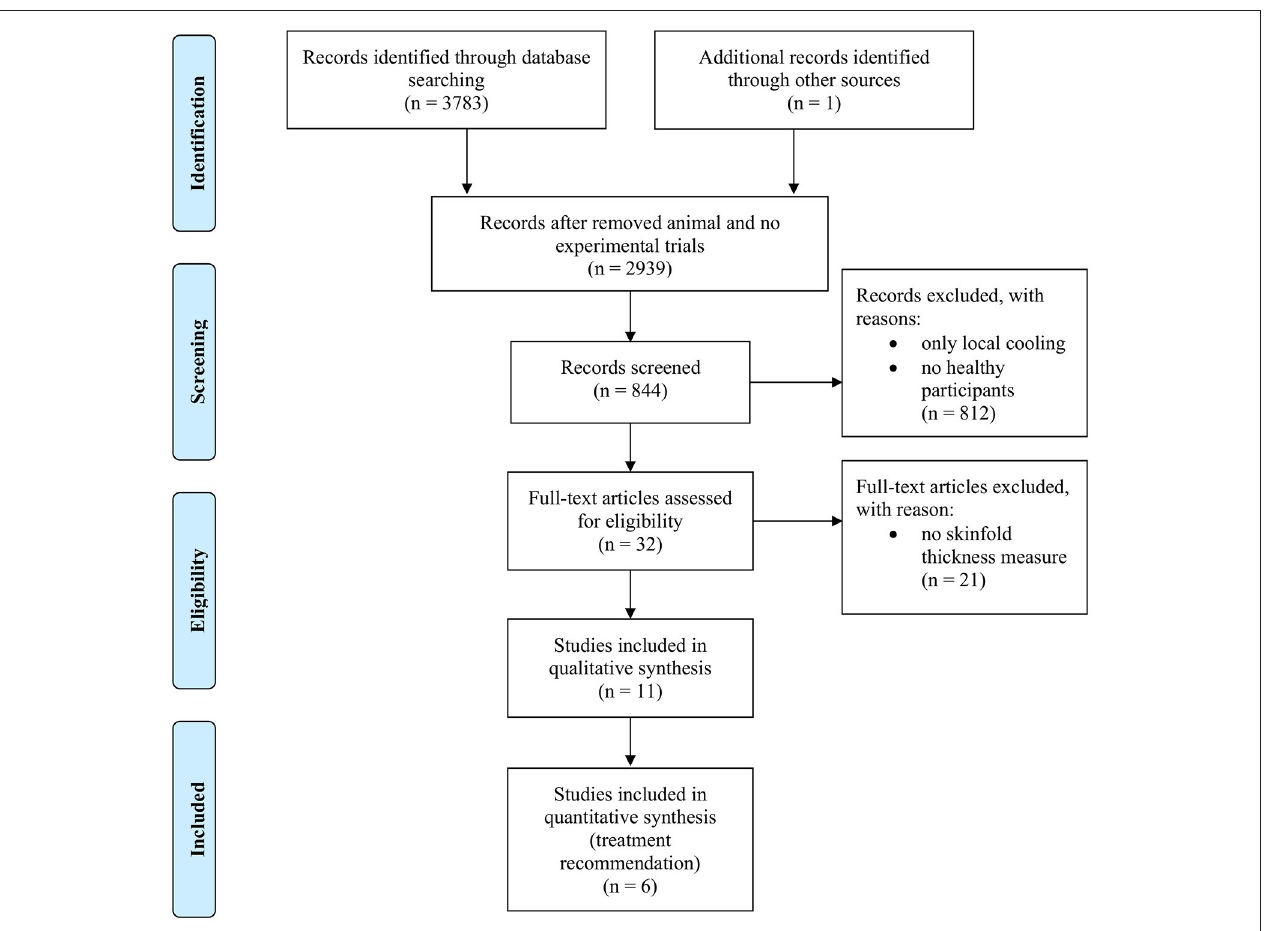
FIGURE 1 | Flowchart describing the systematic search strategy and selection